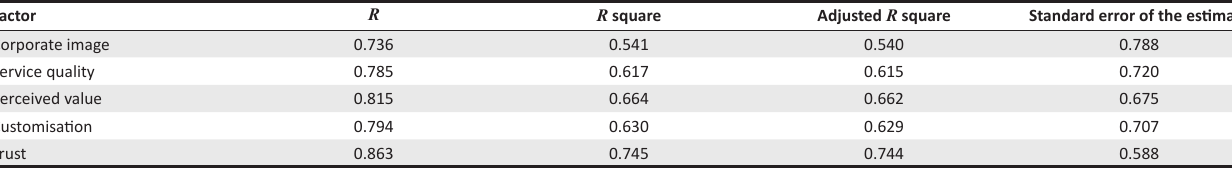
TABLE 4a: Influence of the independent variables on the intervening variable. Model 1 summary. Factor R R square